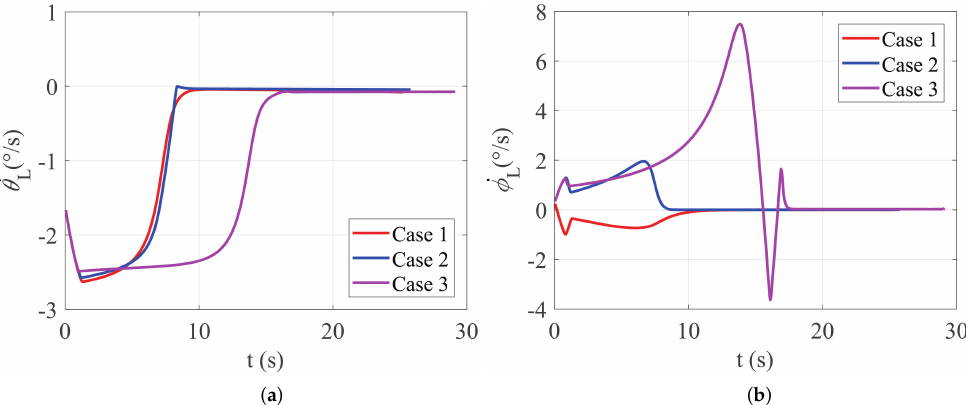
Figure 2. Variations of LOS angles against constant maneuvering targets: ( a ) LOS angles in pitch plane; ( b ) LOS angles in yaw plane.